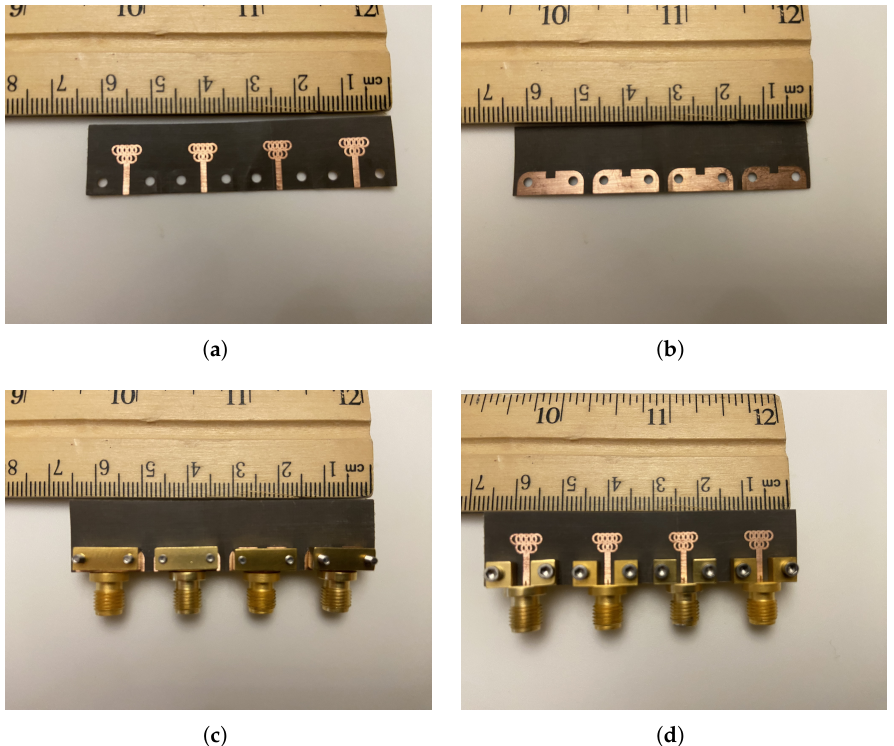
Figure 9. Olympeak MIMO antenna prototype ( a ) without connector front ( b ) without connector back ( c ) with connector back ( d ) with connector front.